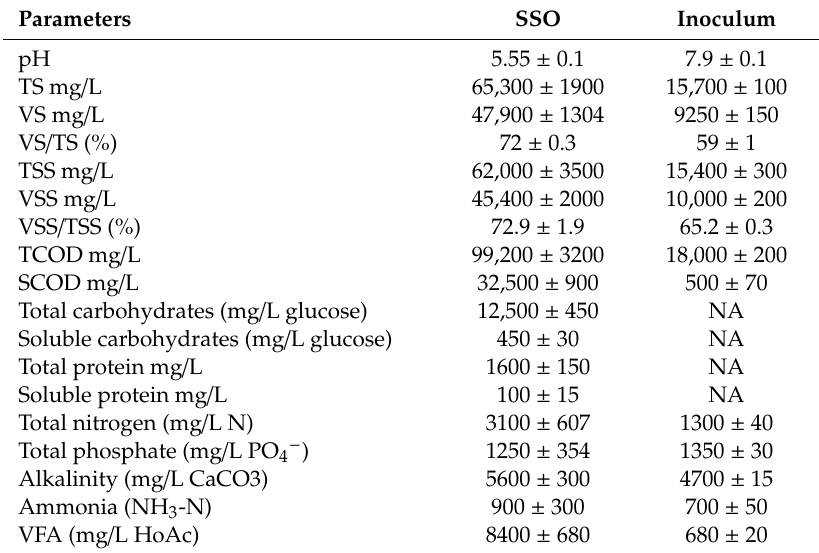
Table 2. The characteristics of SSO and